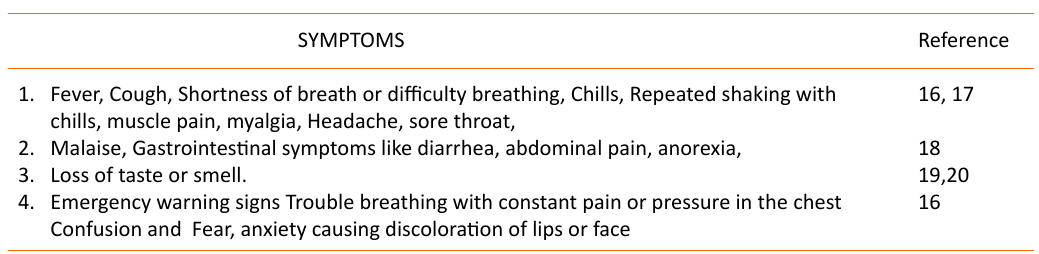
Table 2. Common presenting symptoms